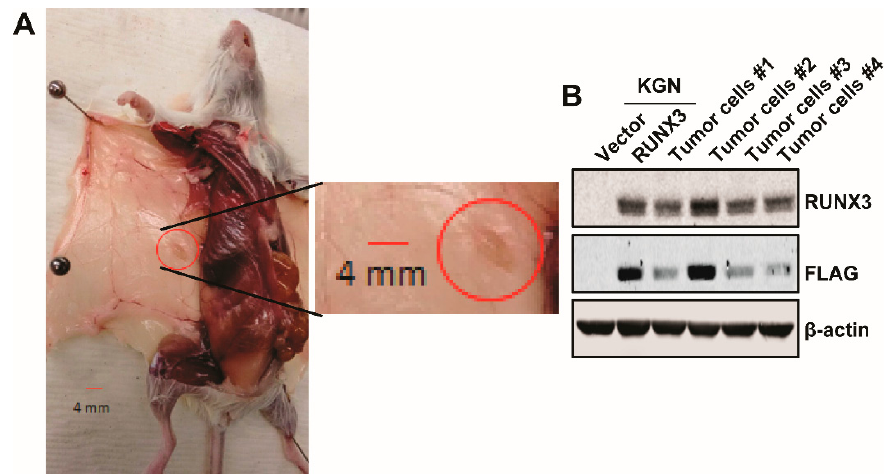
Figure 3. RUNX3 increases tumor formation in KGN cells. KGN / Vector and KGN / RUNX3 cells (2 × 10 7 cells) were injected subcutaneously into the left and right flank, respectively, of female NSG (NOD- scid IL2R-gamma null ) mice twice over an interval of two weeks ( n = 6). ( A ) Image of one KGN / RUNX3 tumor is shown. The left panel shows the location of the tumor. The right panel shows the image of the same tumor at a higher magnification. The scale bar is 4 mm. ( B ) Four KGN / RUNX3 tumors were harvested, dissociated into single cells, and passaged in culture. RUNX3 expression in the tumor-derived cells was examined by immunoblotting using RUNX3 and FLAG antibodies. β -actin was used as the loading control.